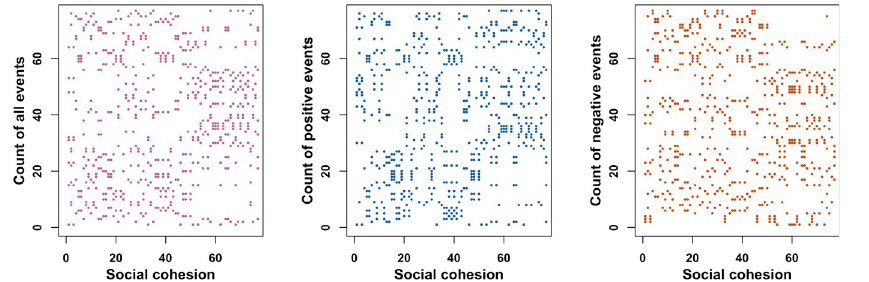
Fig 8. Recurrence plot (RP) for social cohesion and counts of events from target filtered